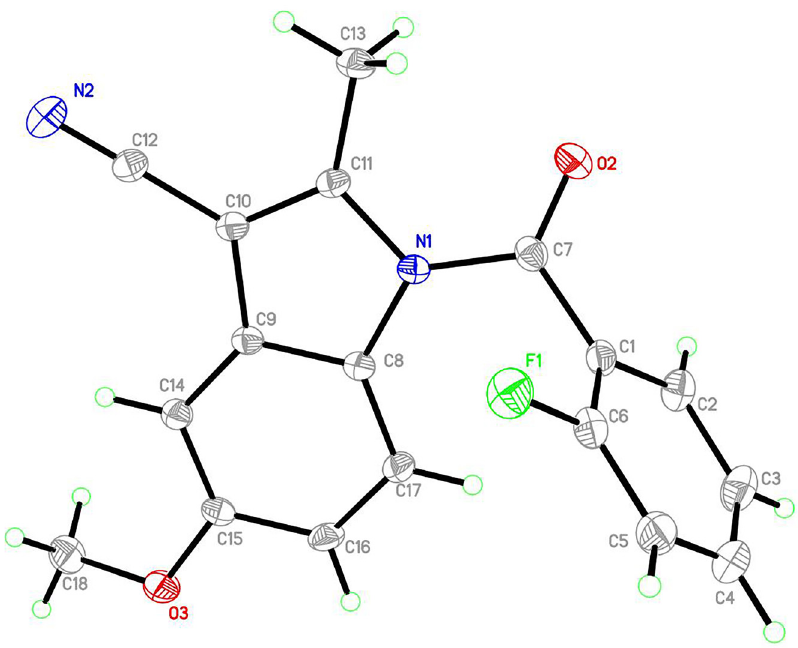
Table  : Data collection and